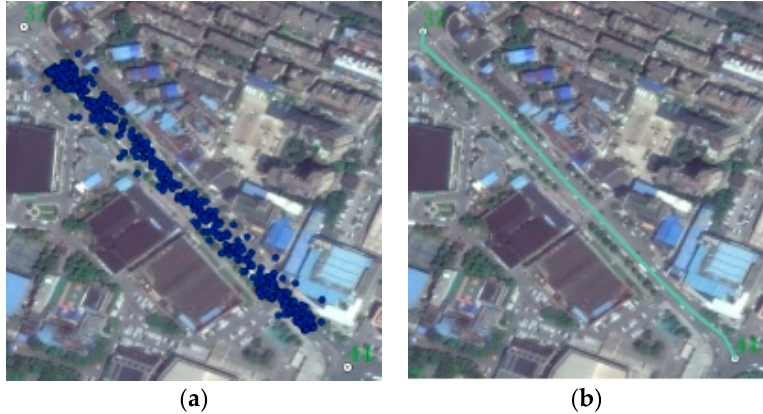
Figure 21. Fitting the road segment-based Multivariate Adaptive Regression Splines (MARS): ( a ) track points belonging to two intersections; ( b ) the fitted result.